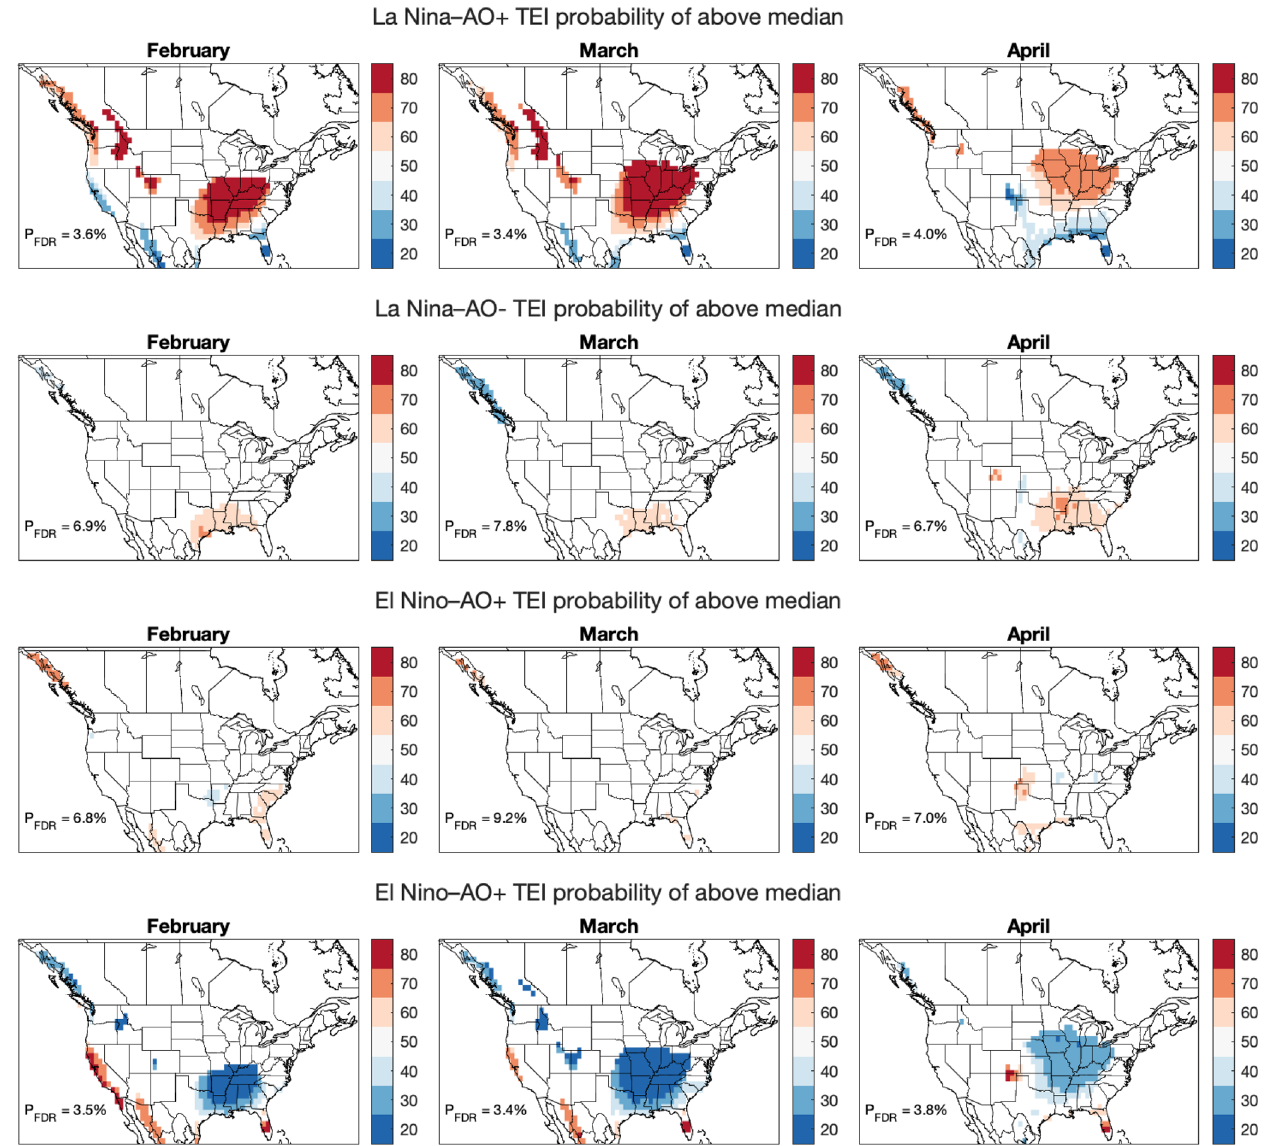
Figure 4. Probabilities of February, March, and April TEI exceeding its climatological median value for bivariate Niño 3.4–AO composites. The color bar is centered on the climatological value of 50%. Statistically insignificant values, locations with composite amplitudes less than 0.05, and shifts away from 50% that are less than 5 percentage points are masked. All statistically insignificant probability shifts away from 50% are less than P FDR , which is shown on each